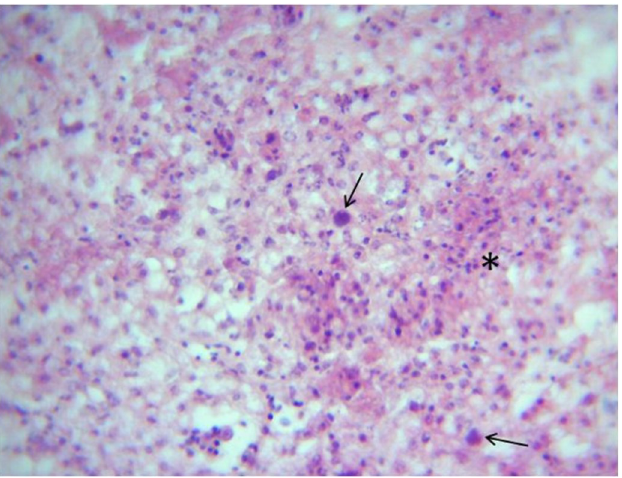
Fig 3. Liver of inoculated chicken at 4dpi–area of severe individual and diffuse hepatic necrosis. Cellular debris necrotic hepatocytes (Asterix) and presence basophilic intra-nuclear inclusion bodies (Arrows). H&E, X400.